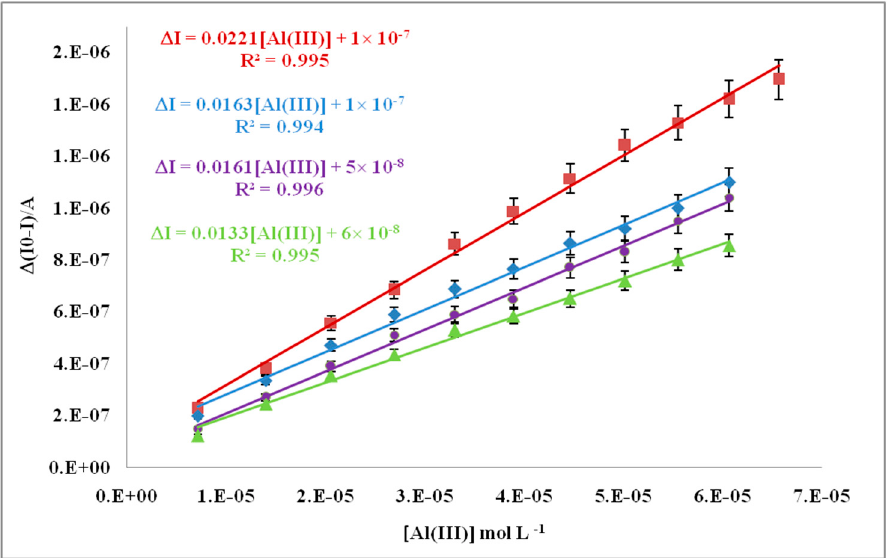
Figure 7. Calibration curves of Al(III) for ( ■ ) SOD/PdNPs/SPC TTF Es; ( ▲ ) SOD/RhNPs/SPC TTF Es